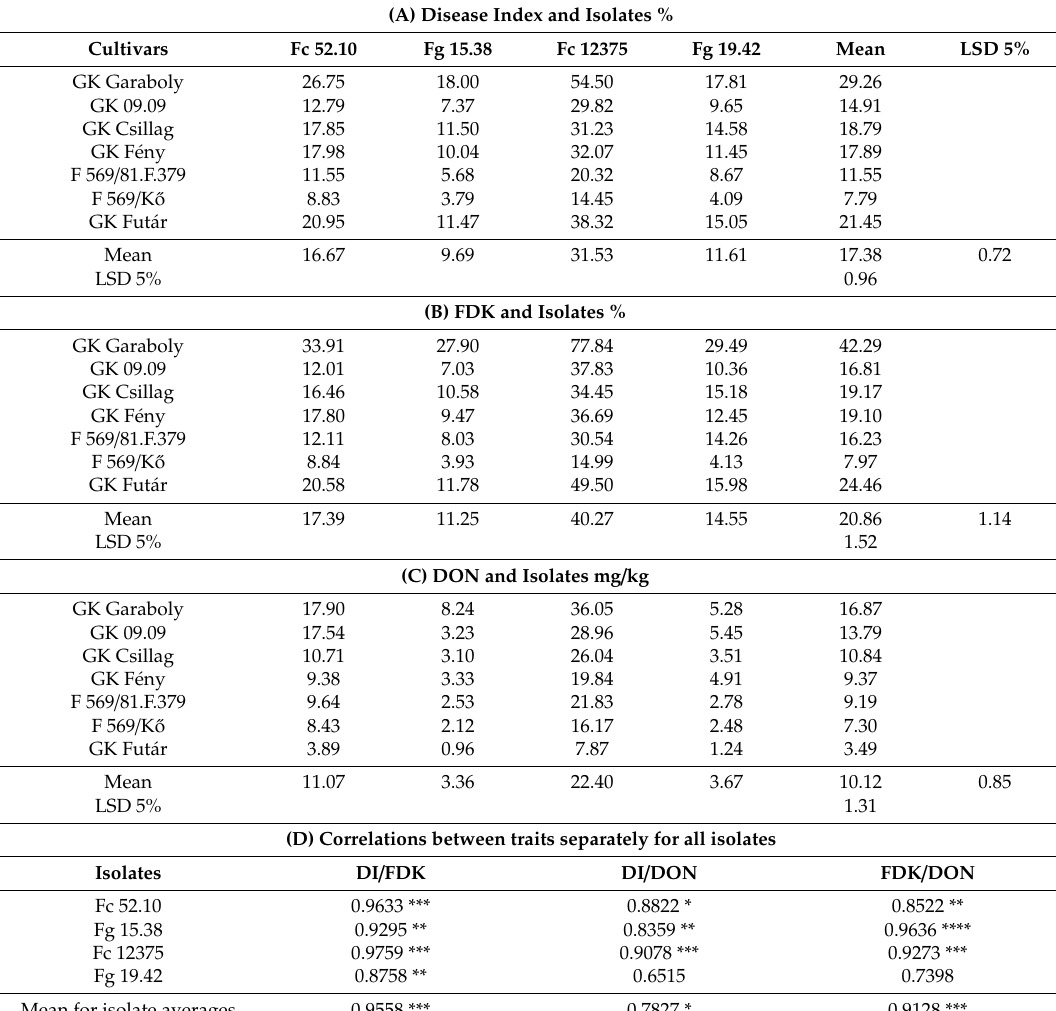
Table 9. The resistance of wheat genotypes against di ff erent Fusarium isolates expressed in DI, FDK and DON responses, 2013–2014. ( A ) Disease Index and Isolates %. ( B ) FDK and Isolates %. ( C ) DON and Isolates mg / kg. ( D ) Correlations between traits separately for all